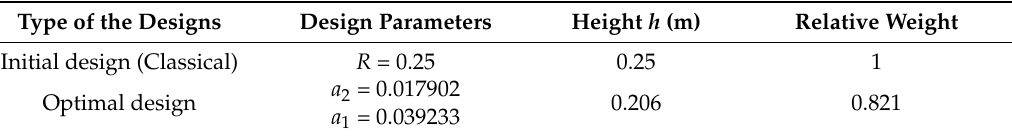
Table 4. Comparison of geometric parameters of a blade.